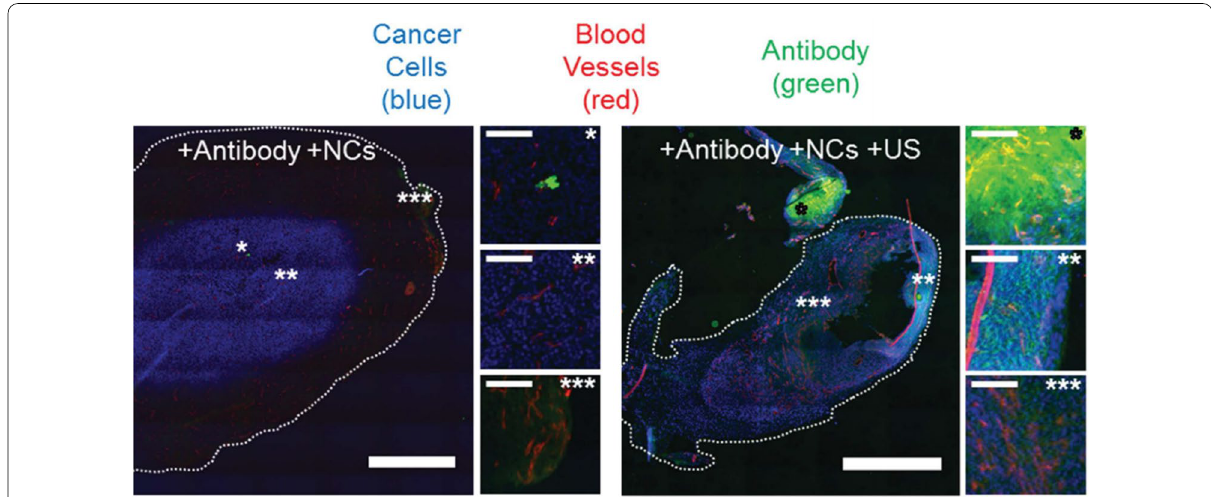
Fig. 10 Representative fluorescence images showing antibody delivery into CT-26 tumors with polymer nanocups and ultrasound exposure. Scale bars are 1 mm in larger images and 0.1 mm in smaller images. Adapted from reference [37], Copyright 2015, John Wiley and